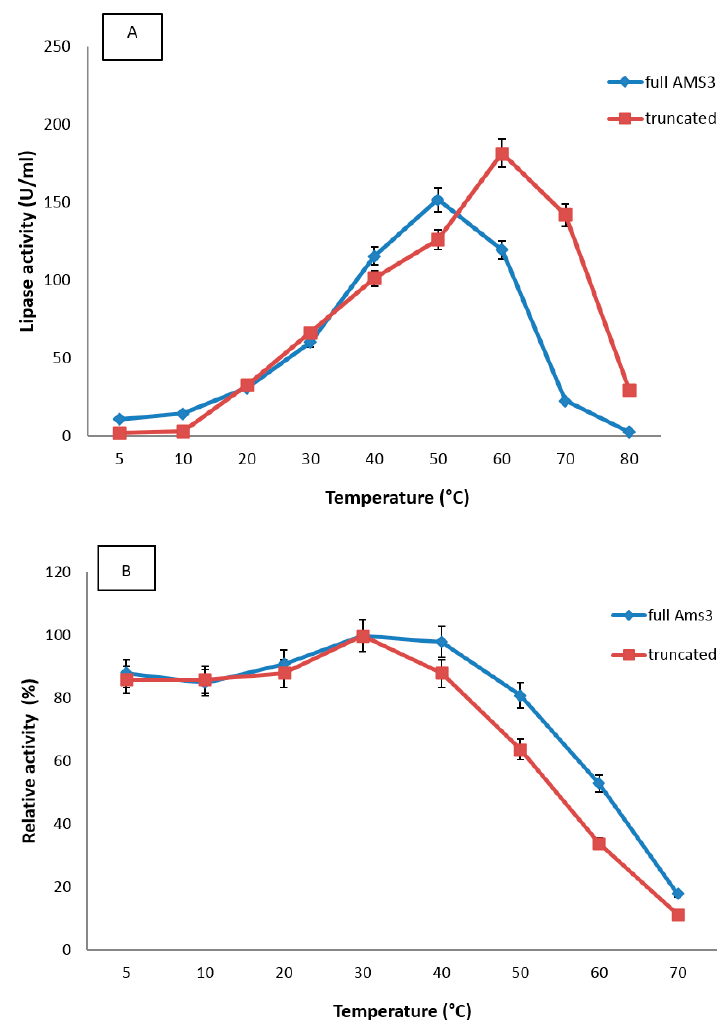
Figure 7. Effect of temperature on purified truncated AMS3 lipase activity. The lipase assay was performed with olive oil as a substrate. ( A ) Enzyme samples were assayed at various temperatures. The temperature that showed the highest lipase activity was considered to be the optimum temperature for the truncated AMS3 lipase; ( B ) Enzyme stability was expressed as a percentage of the control. The enzyme was incubated at various temperatures for 30 min. Assays were performed at optimum temperatures Relative activity was calculated with 30 °C as 100%. Red line: Truncated AMS3 lipase; Blue line: AMS3 lipase. Significant statistical differences according to ANOVA ( p < 0.05).